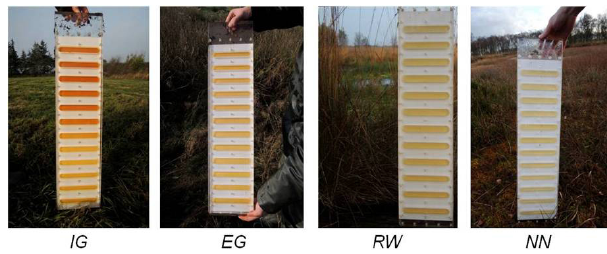
Fig. 2. Pictures of peepers at drained (IG, EG) and wet (RW, NN) sites (sampling date: October